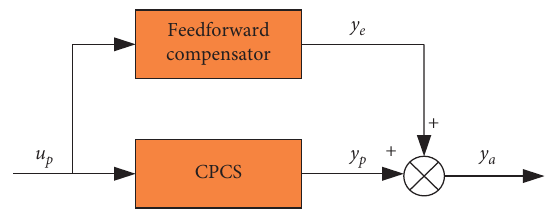
Figure 3: Structure of the controlled